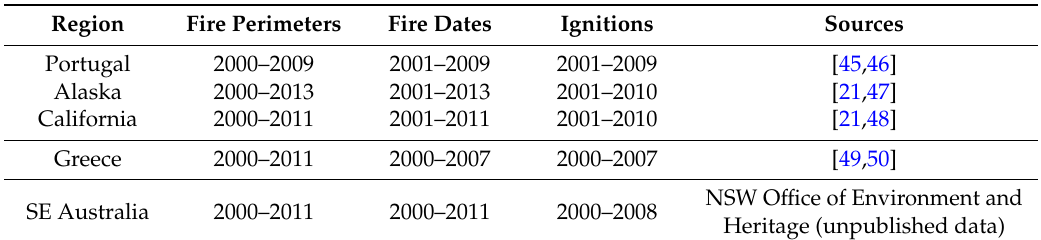
Table 1. Temporal coverage and sources of the fire perimeters and databases containing information on fire dates and